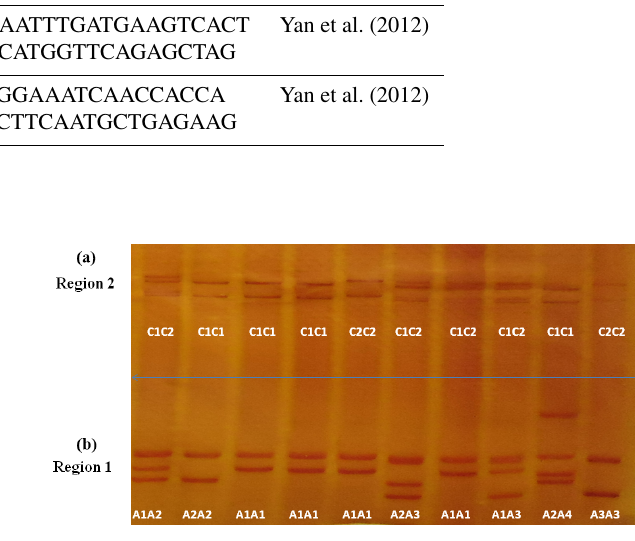
Table 1. List of primer sequences used for PCR. Region amplified Primer sequence Reference